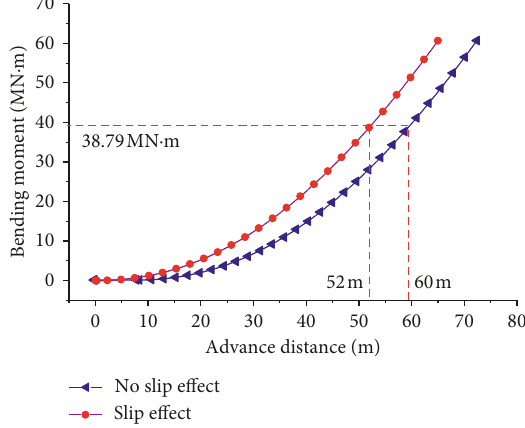
Figure 17: Mechanical calculation of the initial caving intervals of the main roof.